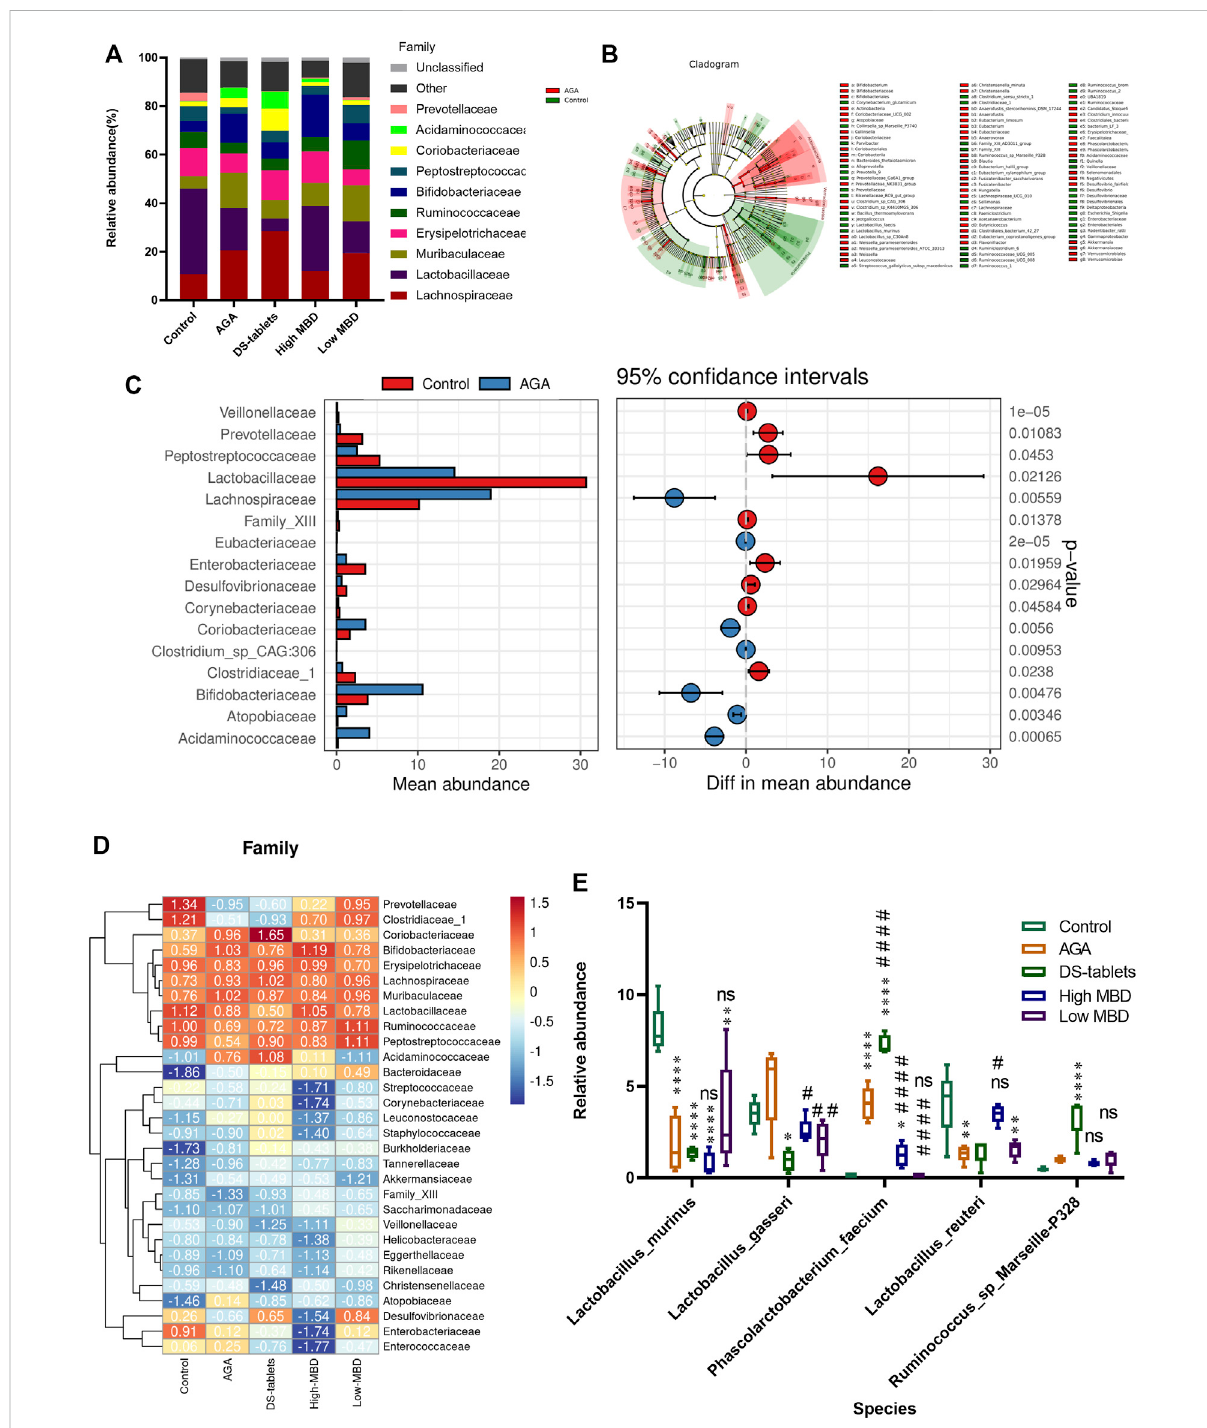
FIGURE 8 Effect of MBD on the relative abundance of various gut microbiota constituents in rats with gouty arthritis. (A) Differences in gut microbiota at thefamily level. (B) LEFSEanalysisbetween thecontrol group andtheAGA group. (C) Differences atthegenuslevel (phylumto specieslevel, fi ltering forspecieswhosesumofabundanceinallsampleswaslessthan0.1%)betweenthecontrolandAGA groupswereanalysedusingWelch ’ s t test,with a threshold of p < 0.05 (or 0.01 ) and a smaller p -value indicating a more signi fi cant difference. (D) Analysis of the correlation between characteristic intestinal fl oraand acute gouty arthritis symptoms. Positive correlationsare displayed inred, andnegativecorrelations aredisplayed in blue. The intensity of the colour is proportional to the correlation coef fi cient. (E) Relative abundance of characteristic intestinal fl ora after MBD